Question: Describe this figure in one sentence.
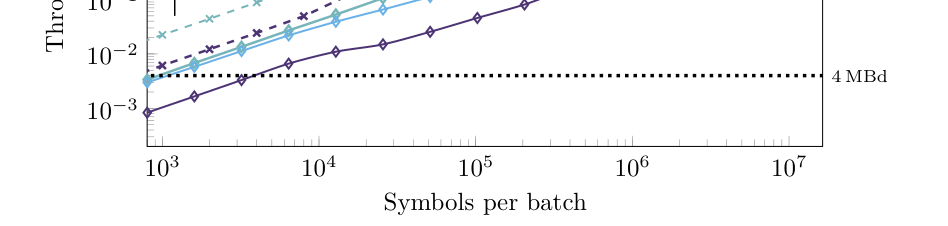
Answer: Comparison of the throughput of the CNN-based equalizer, running on GPU, CPU and FPGA. PT refers to the PyTorch and TRT refers to the TensorRT models.